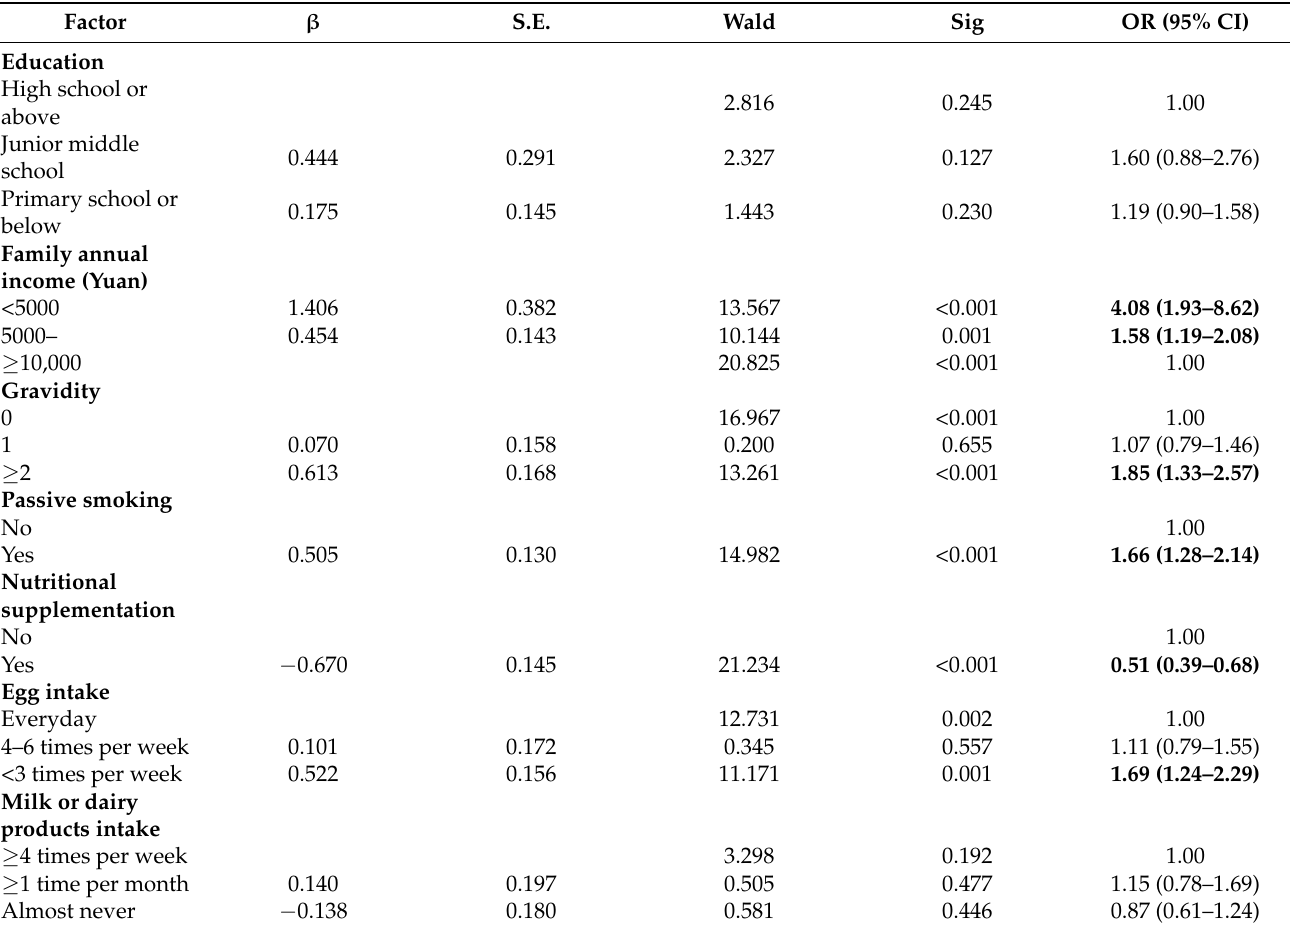
Table 3. Multivariable logistics regression analysis of factors affecting VD